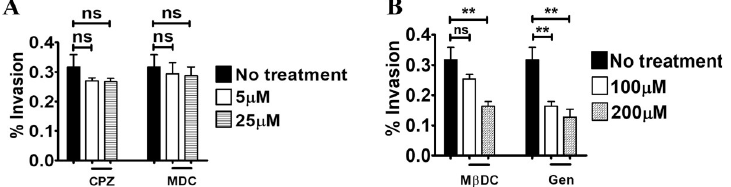
Fig 4. Lipid raft- and caveolin-dependent GBS entry into intestinal cells. Inhibitory effects of endocytosis- disrupting agents on GBS invasion of 5-day-old Caco-2 islets. Cells were infected with GBS in presence or absence of the inhibitors and intracellular bacteria were enumerated by CFU counts in cell lysates after killing extracellular bacteria with antibiotics. ( A ) Effect of chlorpromazine (CPZ) and monodansylcadaverine (MDC) at the non-cytotoxic concentrations of 5 μ M and 25 μ M, respectively. ( B ) Effect of inhibition of cholesterol-rich domains and tyrosine kinase on GBS internalization by methyl-betacyclodextrin (M β DC) or genistein (Gen) at the non-cytotoxic concentrations of 100 μ M and 200 μ M, respectively. Shown are means ± SD of three independent experiments conducted in triplicate. �� , p < 0.01 by one-way Anova and Bonferroni test.